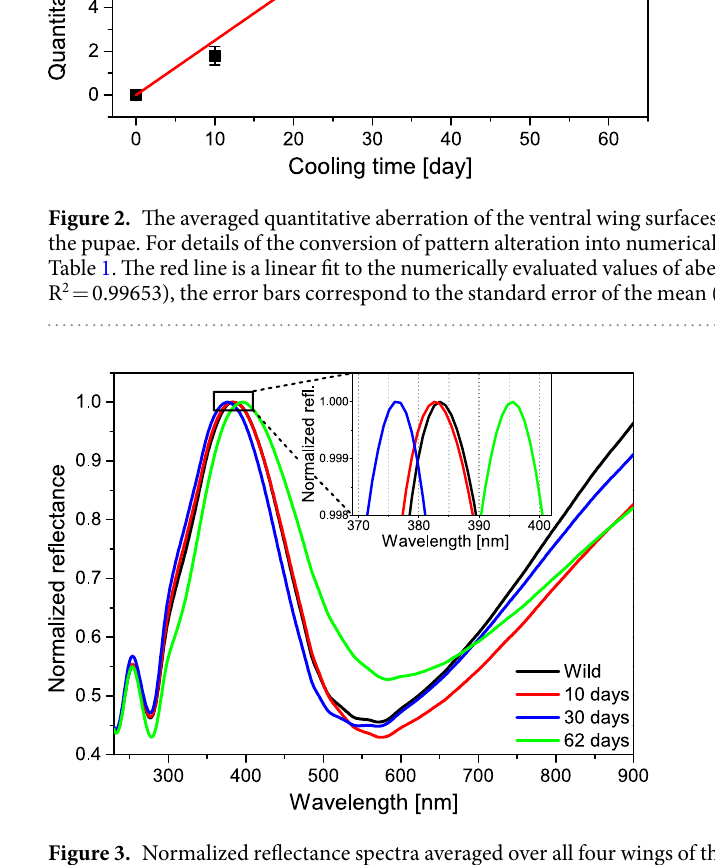
Figure 3. Normalized reflectance spectra averaged over all four wings of the exemplars. Wild males, and males emerged from pupa cooled for 10, 30, and 62 days respectively. The inset shows the peak region of the curves in more